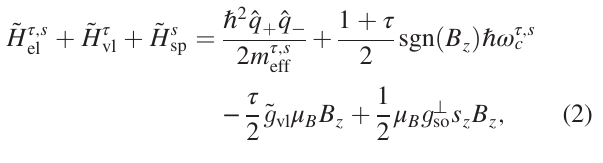
, g ⊥ ) g factors for so sp